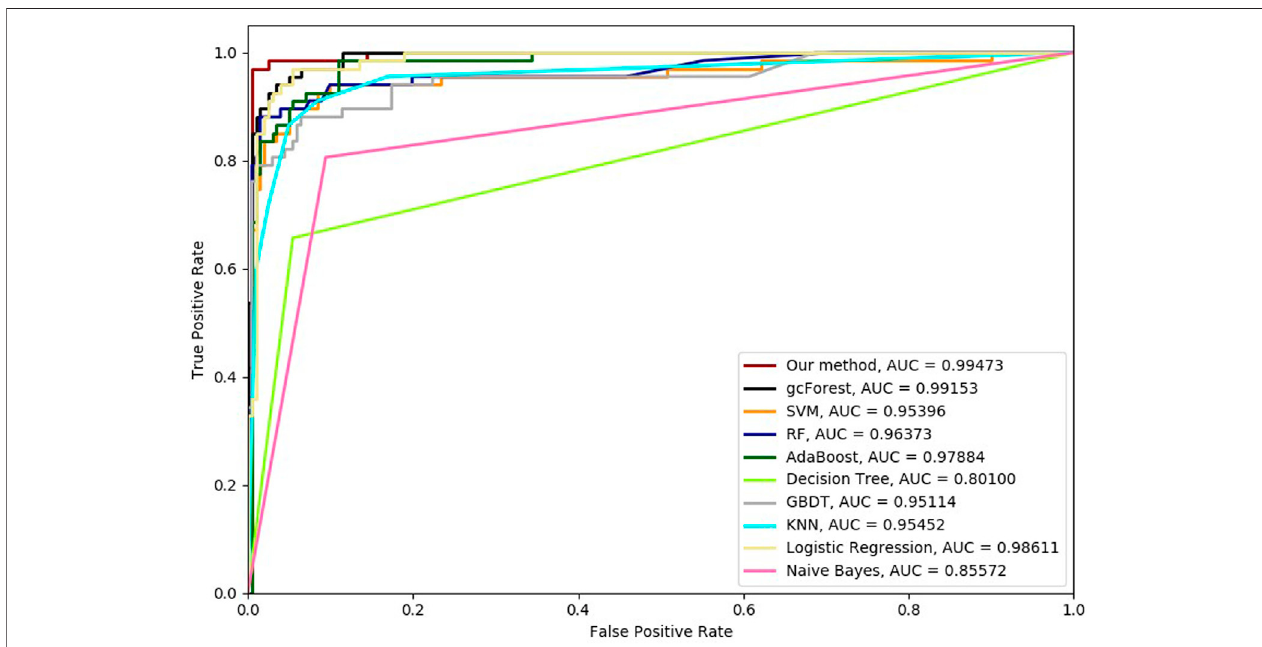
FIGURE 7 | Hypertension-related compound identi fi cation performances of ten methods with 8-cross validation methods.